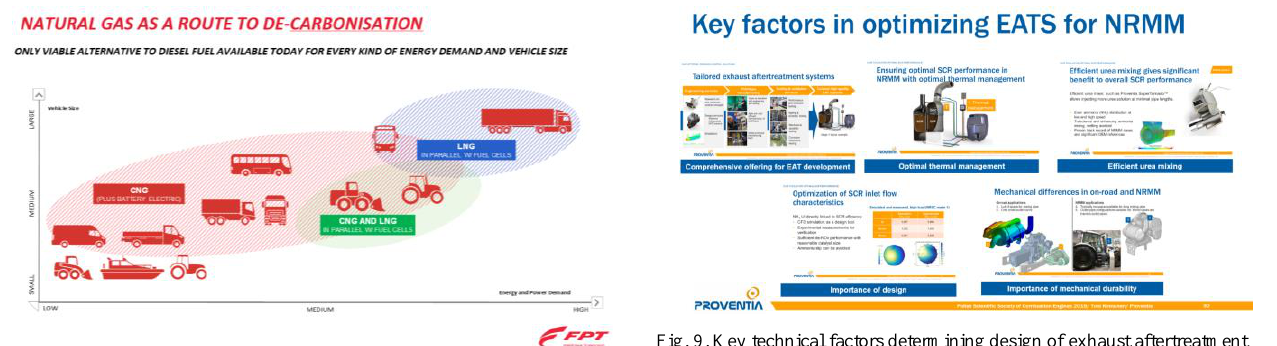
Fig. 9. Key technical factors determining design of exhaust aftertreatment systems in the NRMM sector